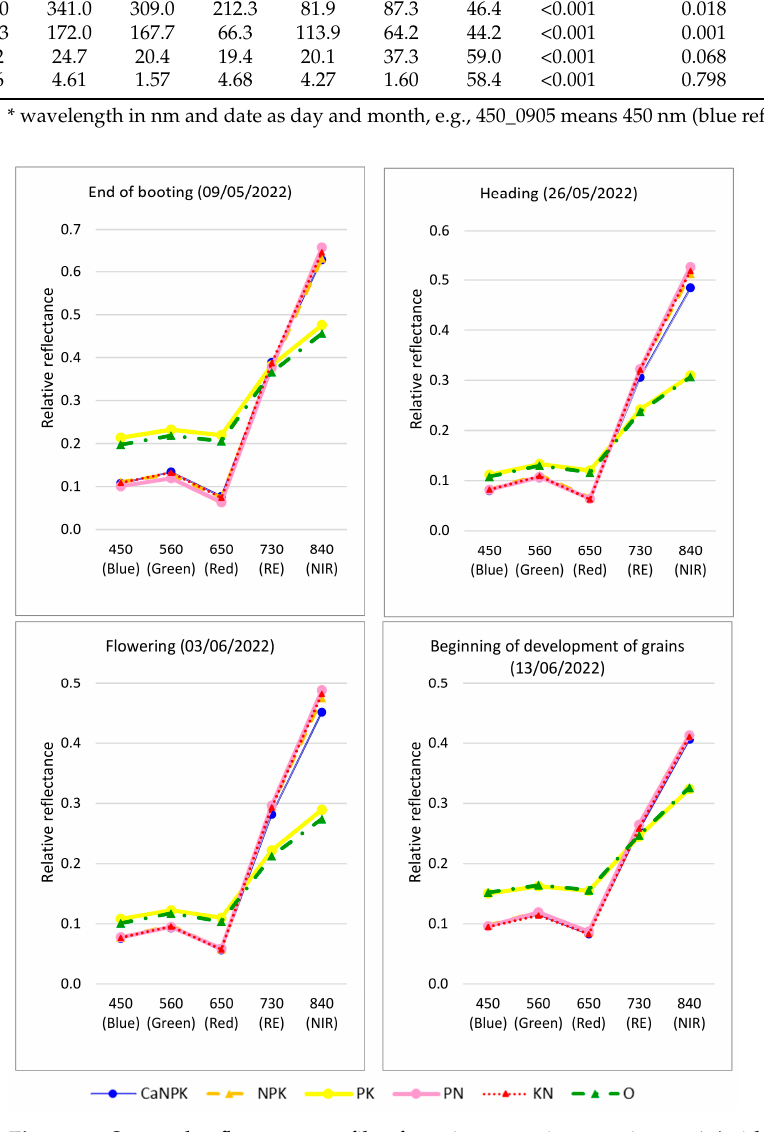
Figure 2. Spectral reflectance profiles for winter rye in experiment 1 (with crop rotation) in four growth stages. In experiment 1 (with crop rotation), the strongest effect on spectral reflectance had nitrogen fertilization. All treatments with nitrogen fertilization had lower spectral reflec- tance for the wavelengths 450 nm (blue), 560 nm (green), and 650 nm (red), and higher